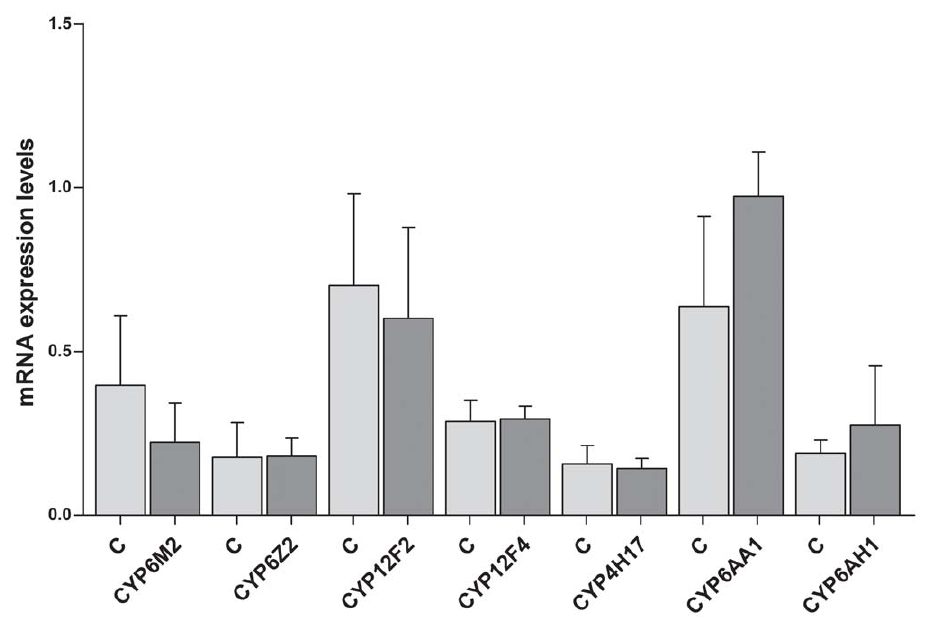
Figure 3. P450 cytochromes mRNA expression levels in control (dsB2M-injected) and CPR silenced (dsCPR-injected) midguts. Midguts were collected 24 hours after a P. berghei infected blood meal. Data are shown as mean 6 SEM.